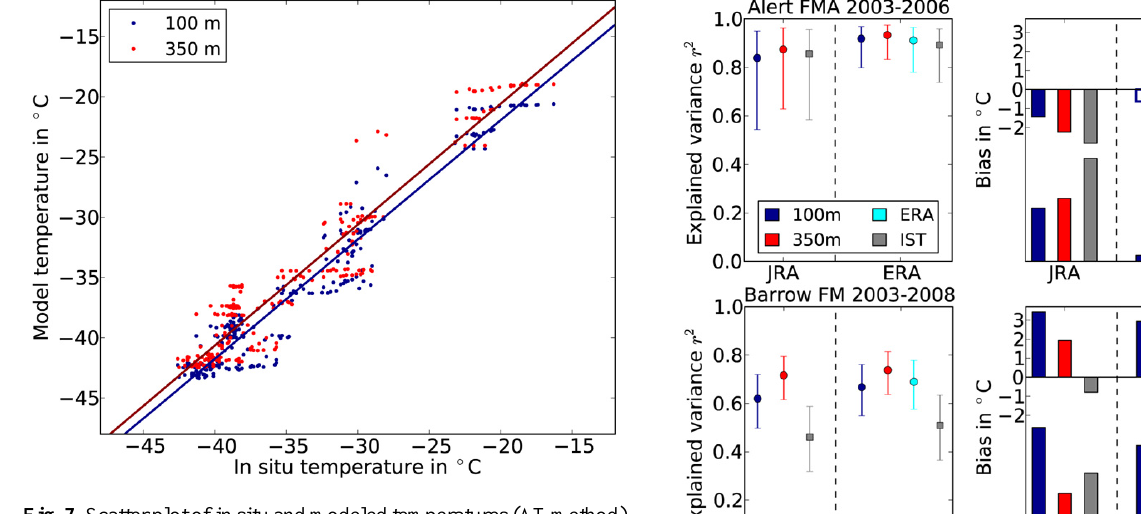
Fig. 7. Scatter plot of in situ and modeled temperatures (AT method) in ◦ C for Alert 2003–2006 for EAA. The colors denote the BL depths and the lines are the corresponding regression lines.